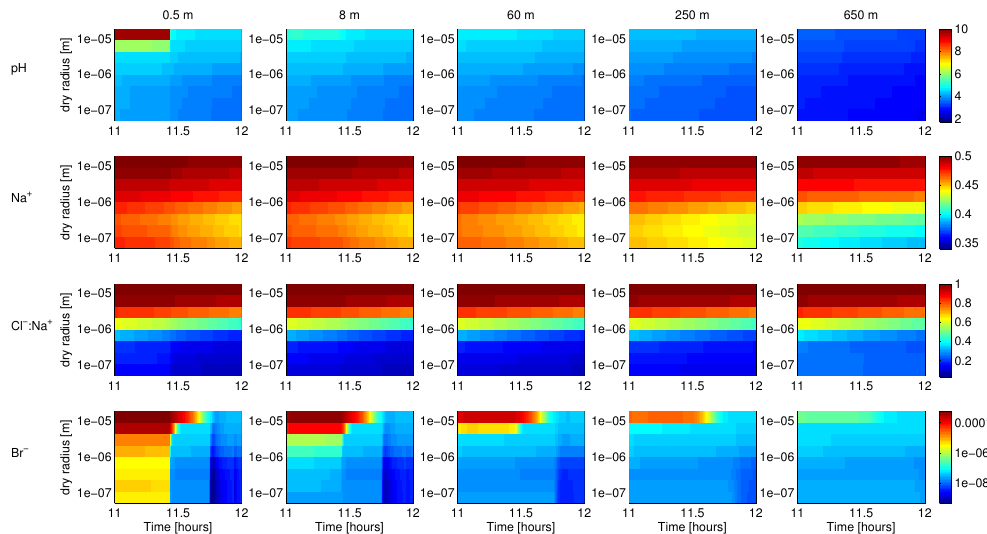
Fig. 5. Seasalt compositional data at different levels through the model column for the base case, low tide, model run. First row is pH. Second and fourth rows are Na + and Br − dry mole fractions, respectively. The third row is the ratio of Cl − and Na + dry mole fractions.